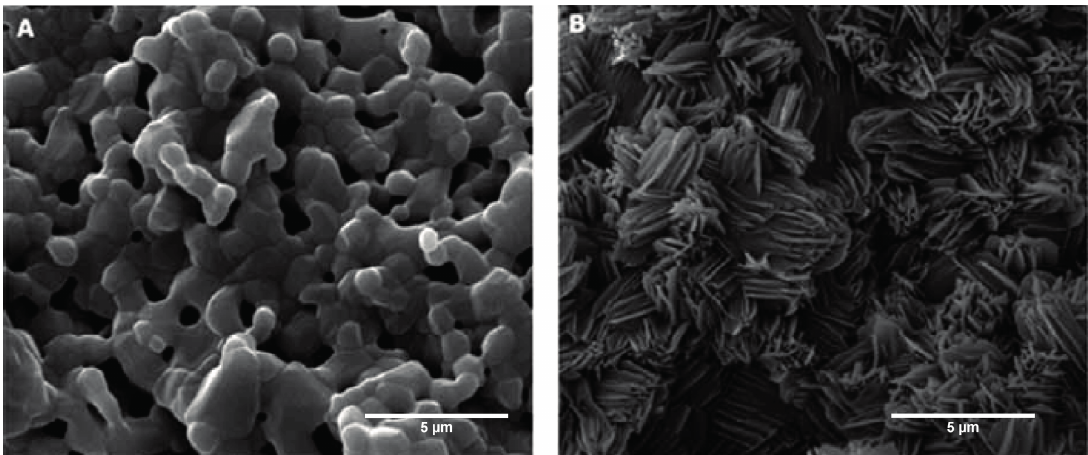
Figure 3. Calcium phosphate based ceramics attract natural apatite deposition on its surface after immersion in physiological solutions. This occurs through an ion exchange reaction between the calcium phosphate in the ceramic coating and the ions and proteins in the surrounding solution. SEM images of BCP (bi-phasic calcium phosphates) scaffolds before and after immersion in phosphate buffered saline (PBS). ( A ) HA/TCP scaffolds before immersion in PBS; ( B ) HA/TCP scaffolds after immersion in PBS for 2 weeks. Note the deposition of apatite crystals on the scaffold surface. Reprinted from [82] with permission from Bentham Open, copyright